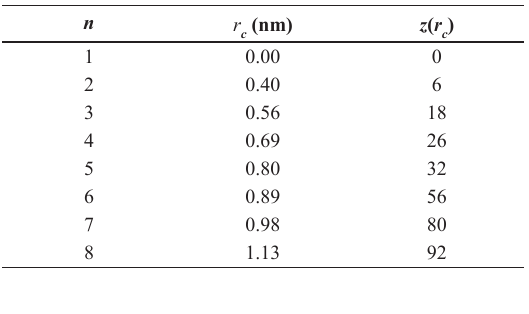
and z(r ) for BaTiO c c